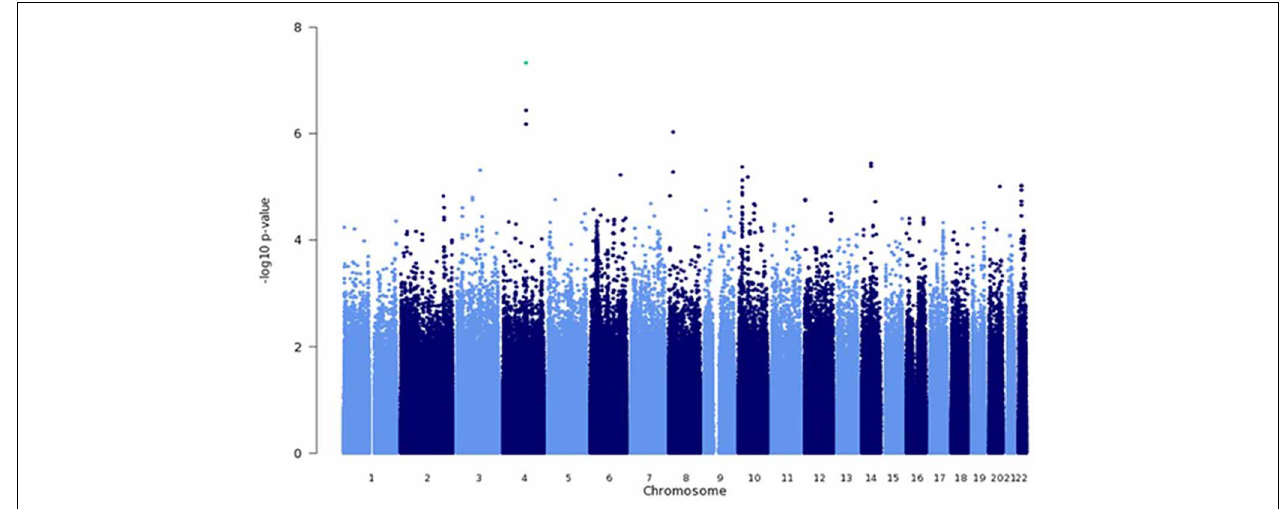
FIGURE 1 | Genome wide association analysis using a mixed linear model. GWAS was performed using a mixed linear model that adjusted for age, sex, education, site, smoking, alcohol consumption, marital status, a history of heart disease, and 1 principle